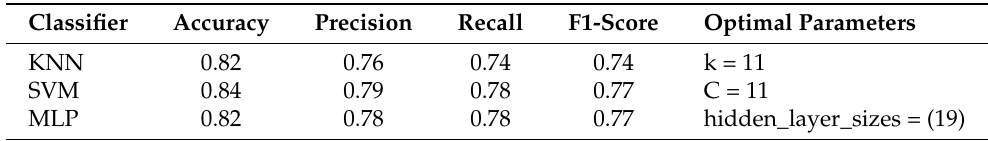
Table 9. Optimal parameters and precision results for each classifier on dataset1